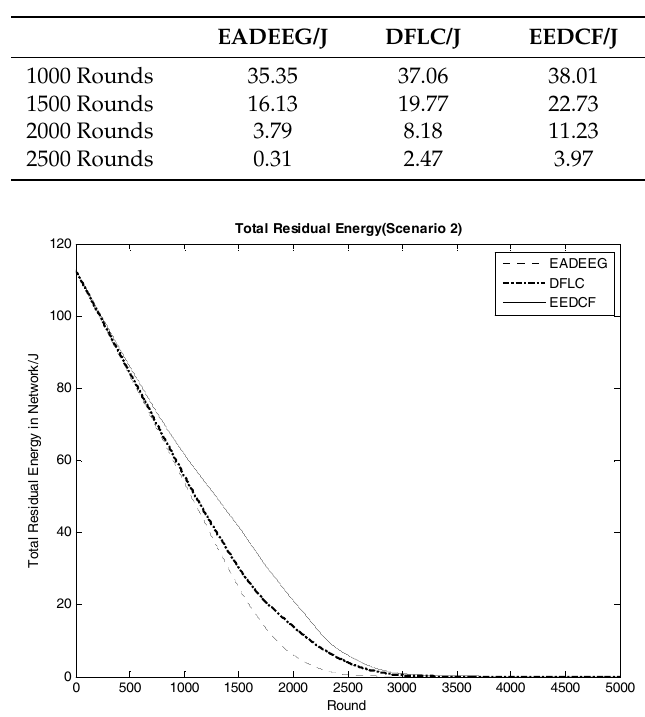
Figure 12. Comparison of system energy consumption of the three algorithms in Scenario 2 (The vertical axis denotes the energy of the system, and the horizontal axis denotes the round number).